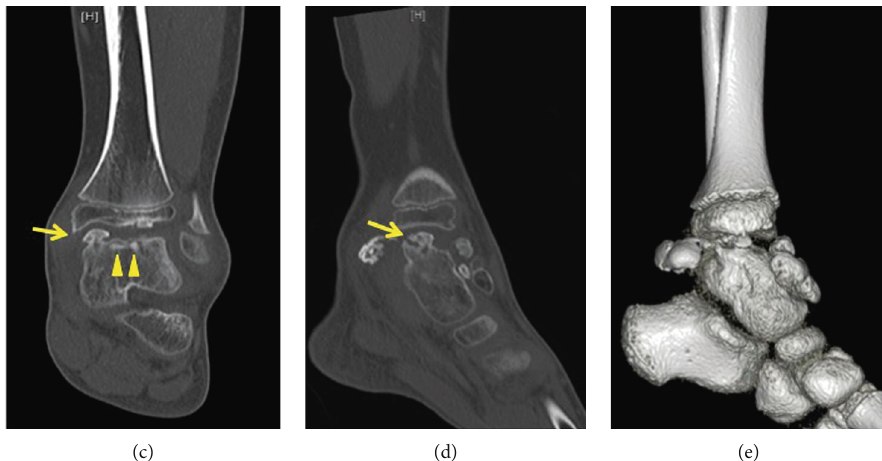
Figure 1: Plain radiograph: (a) anteroposterior image and (b) lateral image. Computed tomography (CT): (c) axial image, (d) sagittal image, and (e) 3-dimensional image. The left ankle plain radiograph showed multiple oval free bodies at the anterior and posterior ankle joint space. CT image showed intra-articular multiple ossi fi ed oval mass lesions (yellow arrowhead), and some protrusions arose from the talus (yellow arrow).